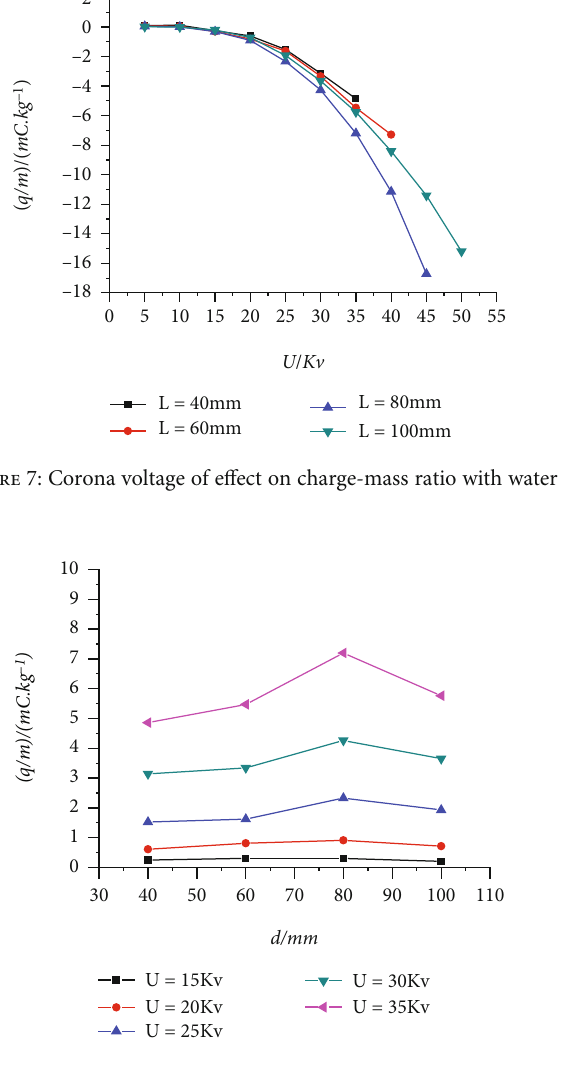
Figure 8: Discharge distance of e ff ect on charge-mass ratio with water mist.